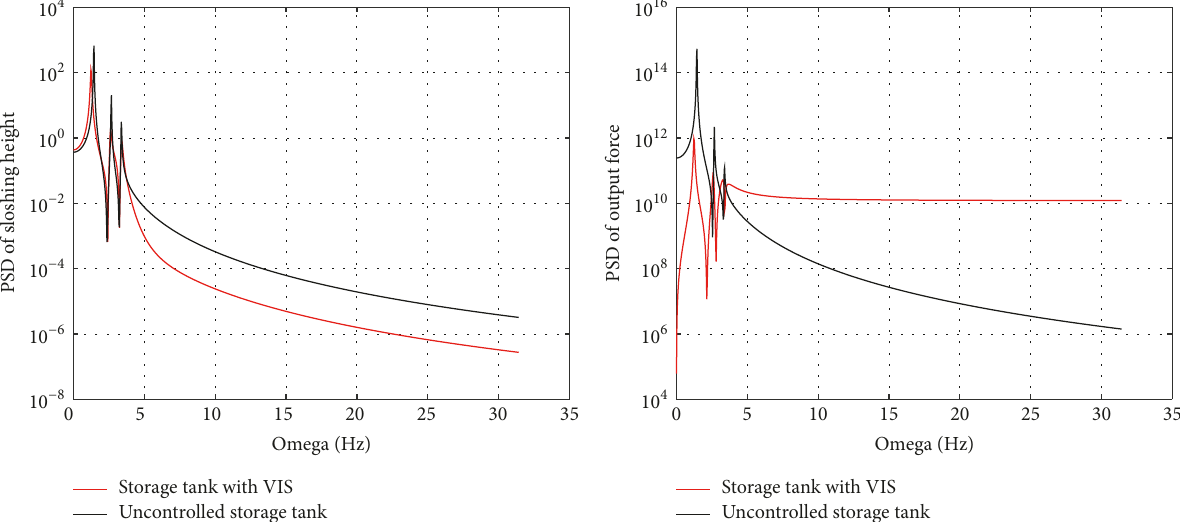
Figure 5: Power spectral density (PSD) curves of the tank with VIS ( 𝜇 𝑐 = 0.5 , 𝜇 𝑚 = 0.5 , and 𝑠 = 1.5 ) and the uncontrolled